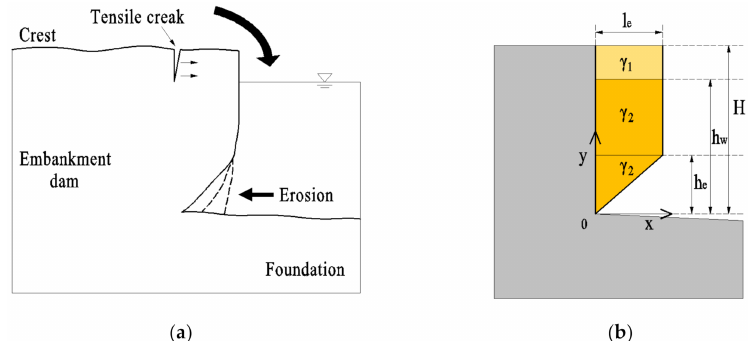
Figure 1. ( a ) The headcut migration process of a side slope due to hydraulic soil erosion during the breach widening process. ( b ) Sketch of a headcut and coordinate system of an eroded